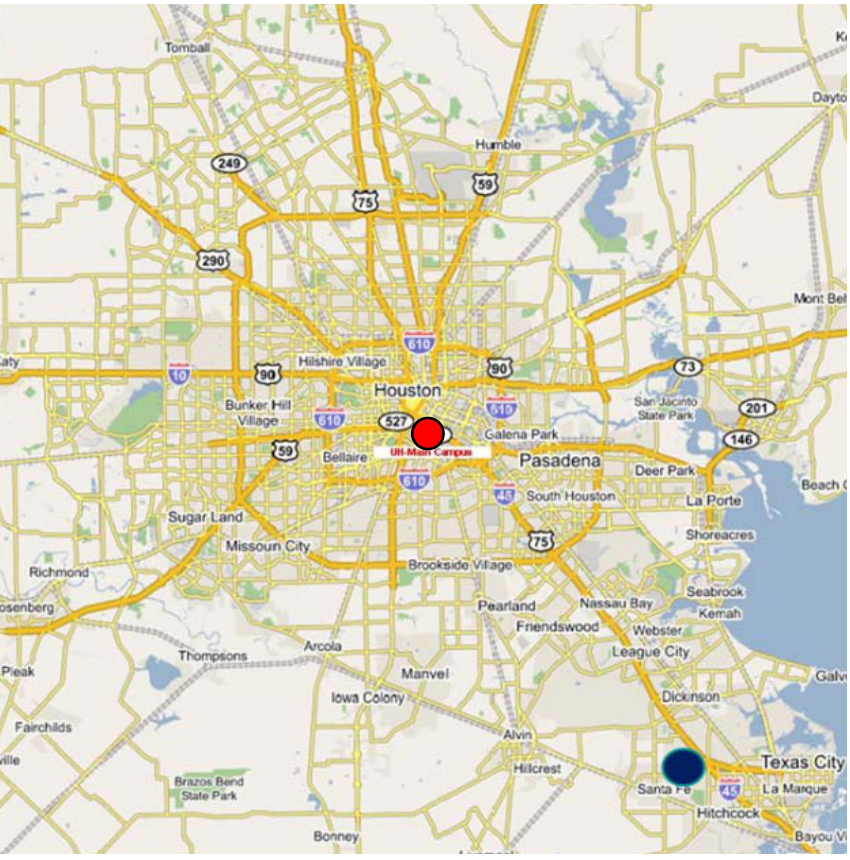
Figure 1. Location of model and measurements. The dark blue dot represents the UH Coastal Center and the red dot represents the UH main campus where the radiosondes were launched.